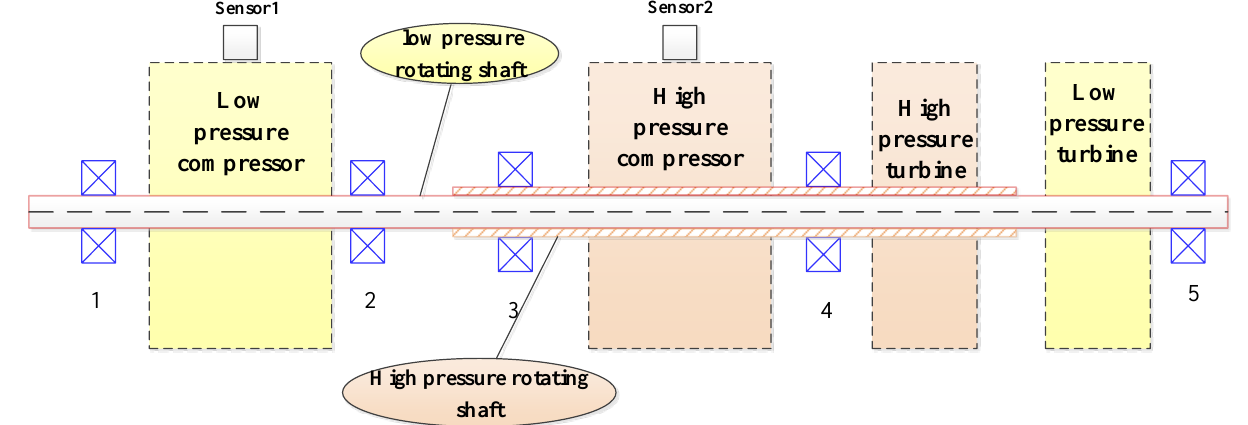
Figure 5. Schematic diagram of gas turbine vibration test.